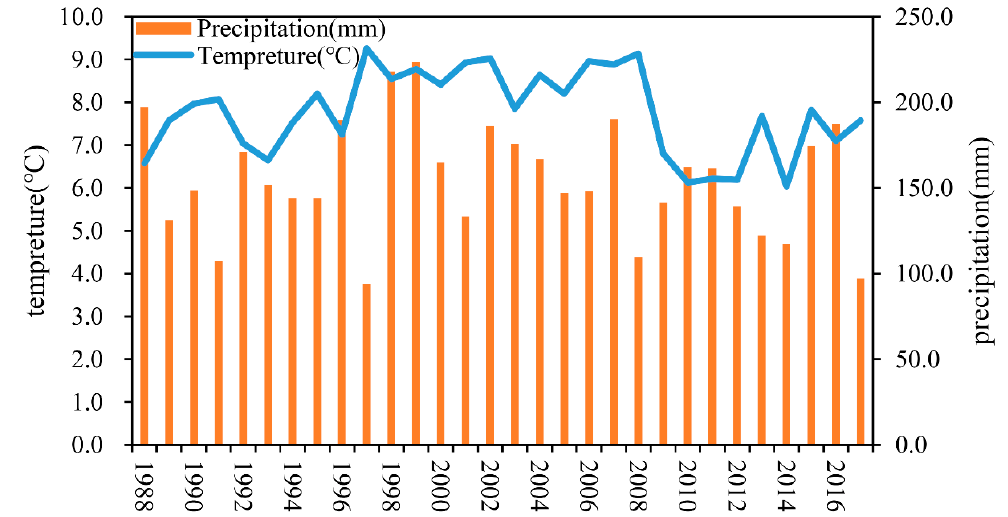
Figure 3. Annual temperature and precipitation data for the study site from 1988 to 2017.